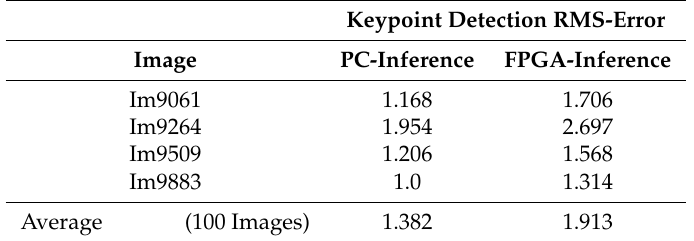
Figure 17. Performance of FPGA/MPSoC Inference vs. PC-based Inference. Table 7. Performance of FPGA-based Inference vs.